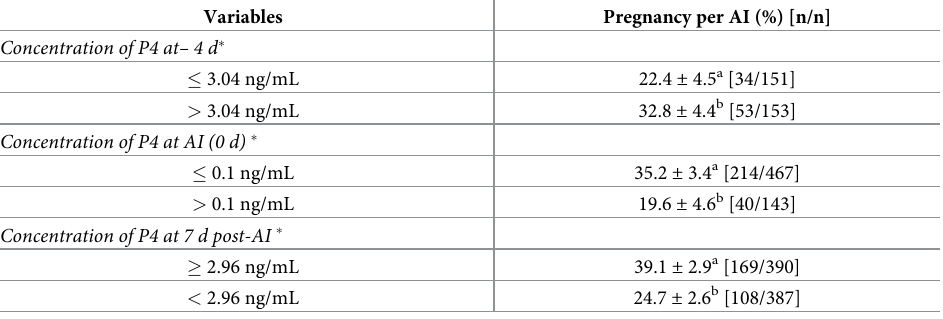
Table 3. Pregnancy per AI, in Experiment 1, according to the concentration of progesterone at—4 d, at the day of AI (0 d) and 7 d post timed AI.